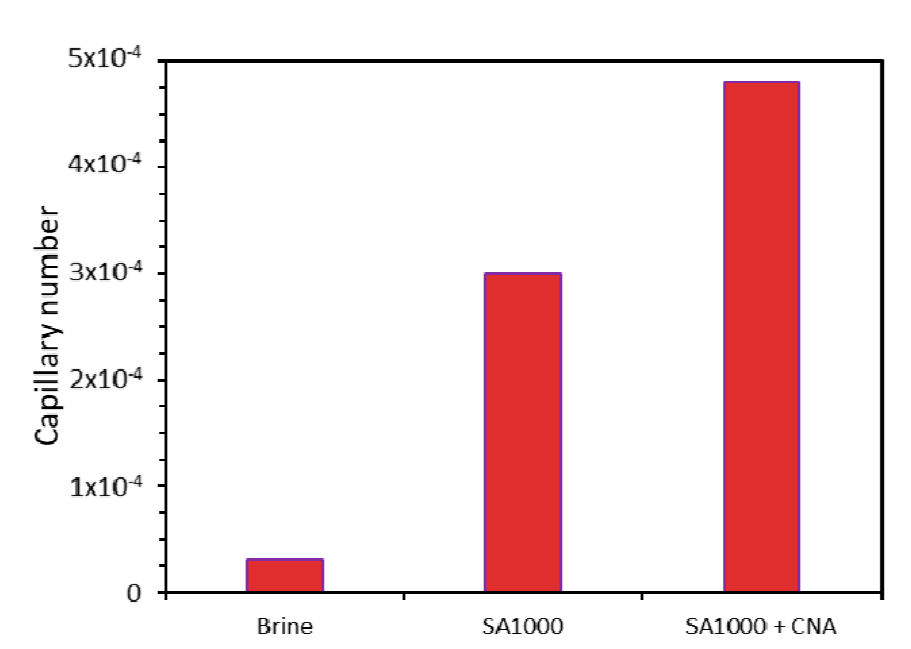
Figure 14. Capillary number ( N C ) estimated at a shear rate of 7 s − 1 and the respective viscosity of the brine and dispersions in the absence and presence of the evaluated nanoparticles at a fixed concentration of 100 mg·L − 1 .